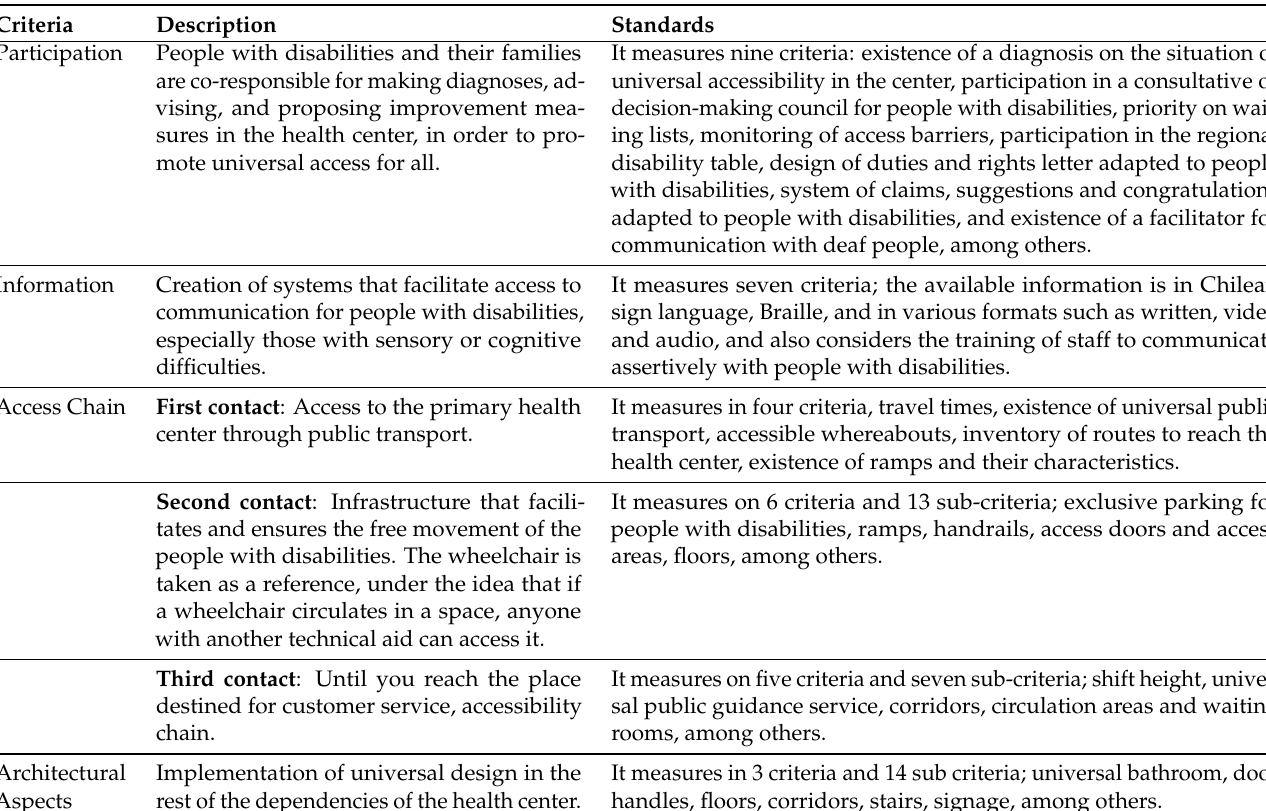
Table 1. Criteria evaluated in the universal access comparison guideline in PHC